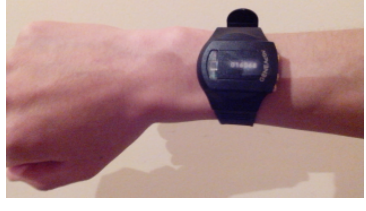
Figure 2. Device used to collect the data.